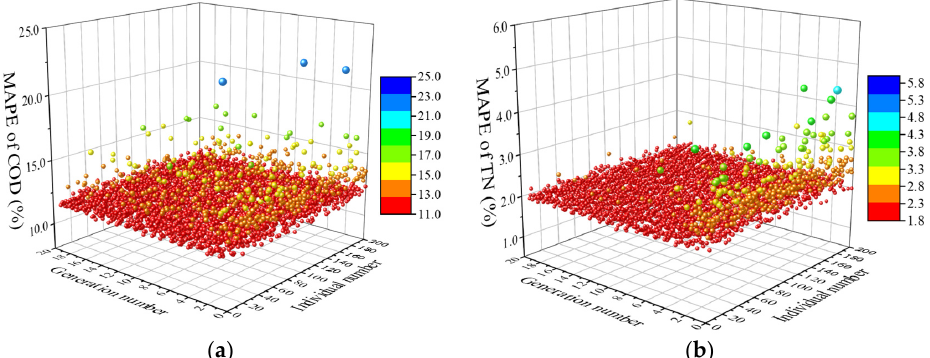
Figure 6. Modeling prediction performance as a function of GA generation and individual number for effluent water quality for ( a ) COD and ( b ) TN, respectively.